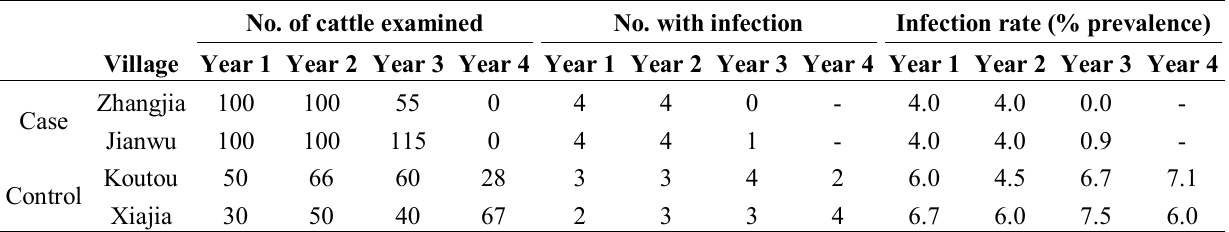
Table 3. The results of fecal examination on the livestock (water buffalo). No. of cattle examined No. with